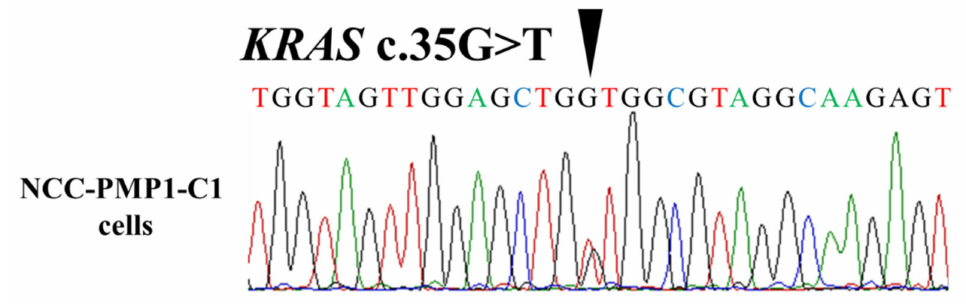
Figure 3. KRAS somatic mutation in NCC-PMP1-C1 cells.